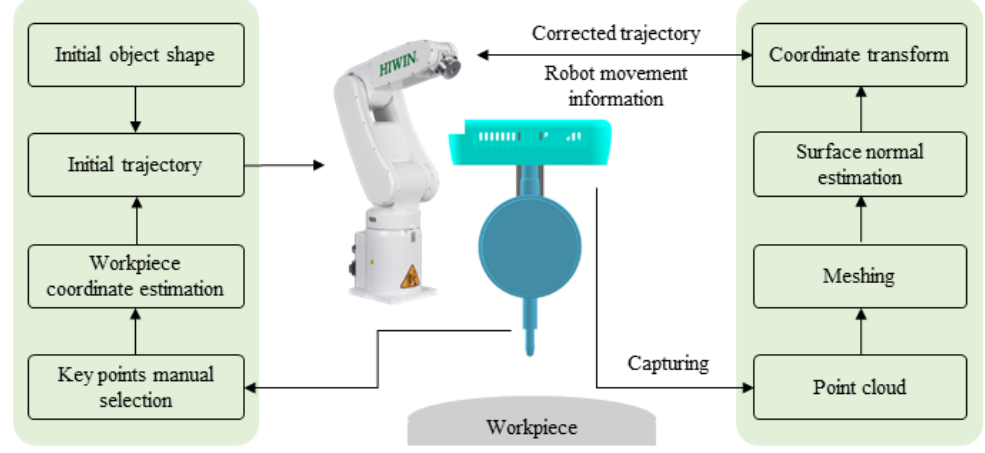
Figure 1. Proposed methodology for desired path tracking and surface normal trajectory